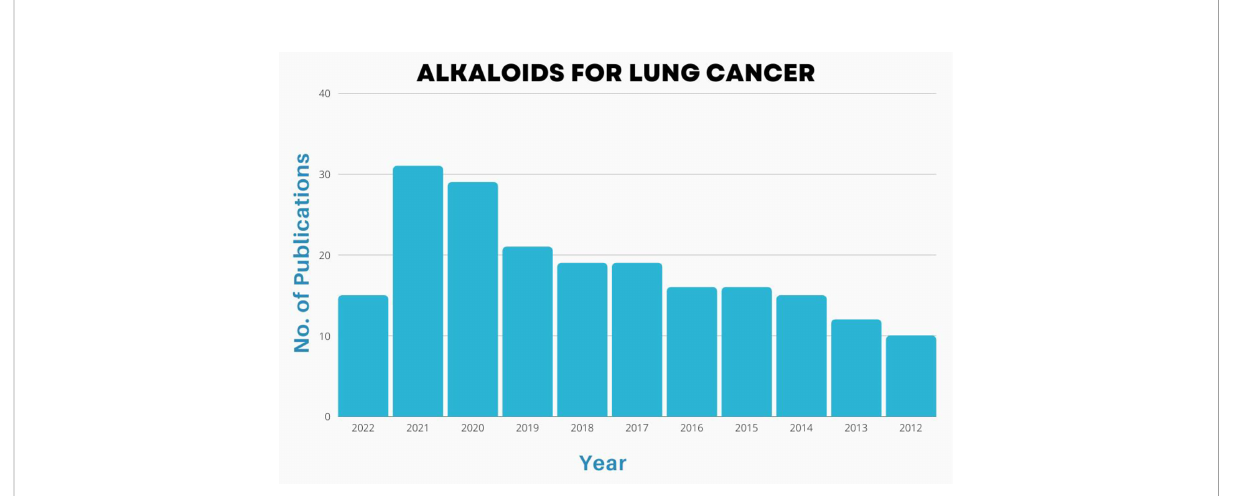
FIGURE 4 Number of publications [2002-2022] on basis of alkaloid application in treatment of lung cancers.